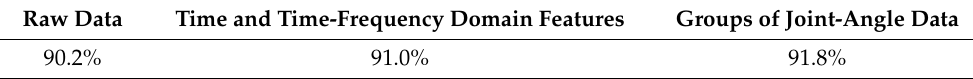
Table 6. Classification results of Ninapro DB5 with different inputs.